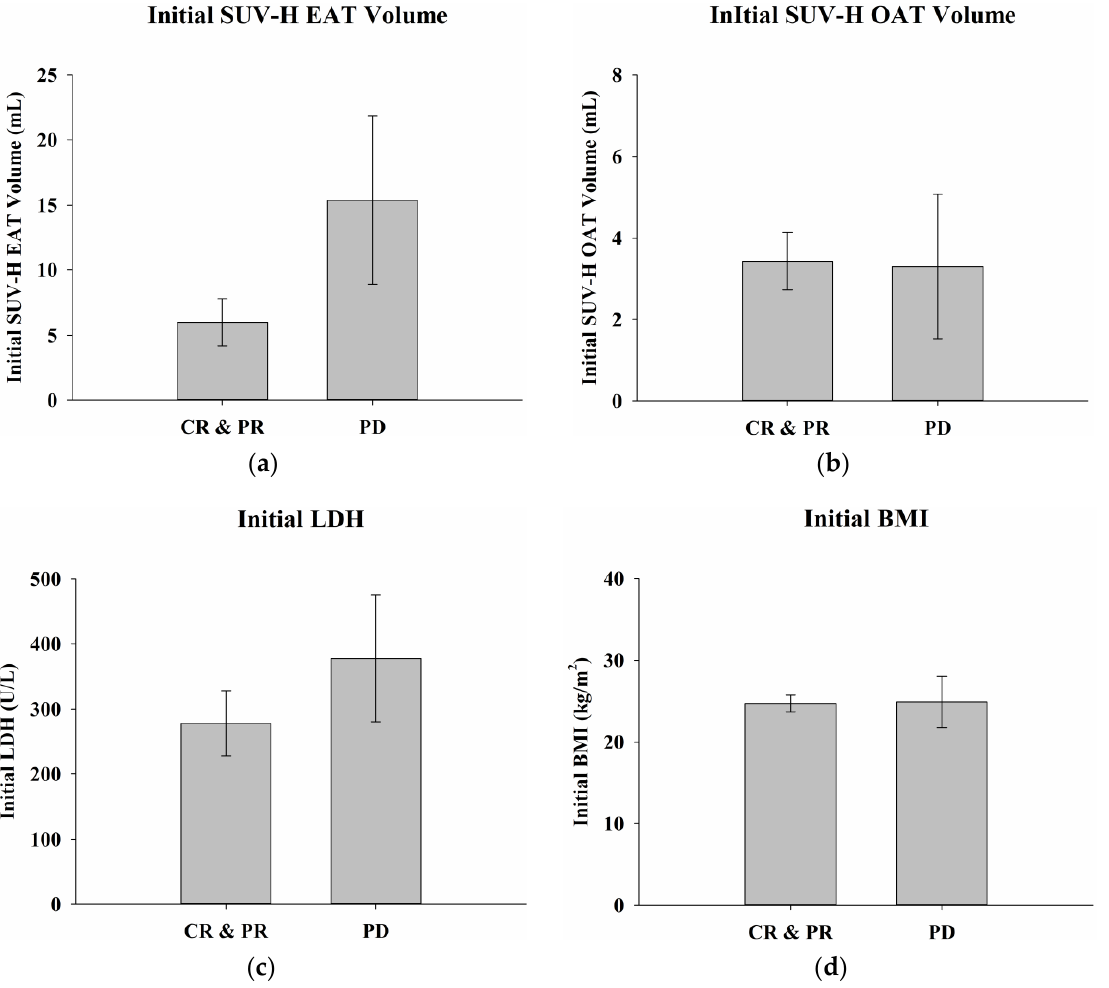
Figure 5. Initial SUV-H EAT and SUV-H OAT volumes, serum LDH levels, and BMI with different treatment responses. There were no statistically significant differences in ( a ) SUV-H EAT volume, ( b ) SUV-H OAT volume, ( c ) serum LDH levels, or ( d ) BMI between responders and non-responders before treatment, with p values of 0.08, 0.94, 0.43, and 0.95, respectively. SUV-H EAT, high standardized uptake value epicardial adipose tissue; SUV-H OAT, high standardized uptake value orbital adipose tissue; LDH, lactate dehydrogenase; BMI, body mass index; CR, complete response; PR, partial response; PD, progressive disease.